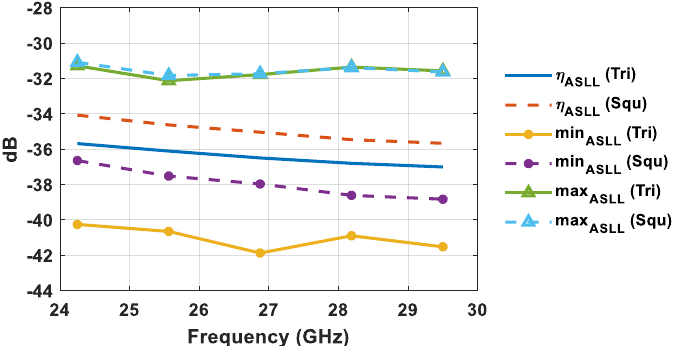
Figure 10. ASLL statistical comparison of square and equilateral triangular lattices by considering the circular sector cell.